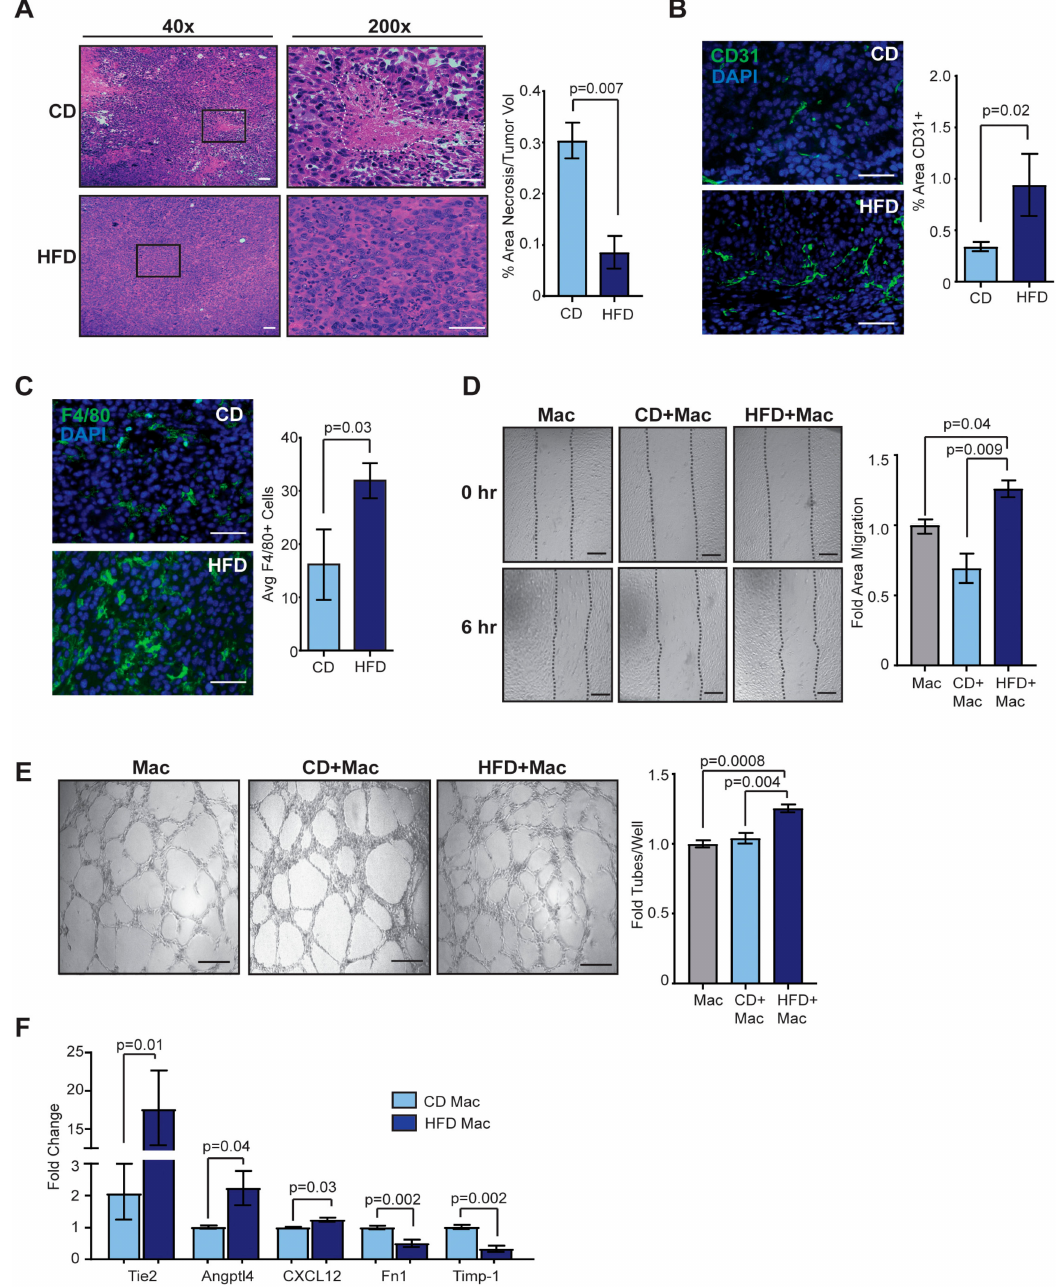
Figure 3. Tumor associated macrophages (TAMs) interact with tumor cells from obese mice to promote angiogenesis. ( A ) Necrotic area was quantified from Met-1 tumors isolated from lean or obese mice ( n = 10 / group, t -test). CD31 expression ( B ) and F4 / 80 + TAMs ( C ) were detected using immunofluorescence and quantified in Met-1 tumors ( n = 6 / group, t -test). Isolated Met-1 tumor cells were co-cultured with THP-1 di ff erentiated macrophages and conditioned media was collected. Human umbilical vein endothelial cells were plated in wound healing assays ( D ) and networking assays ( E ) in the presence of conditioned media ( n = 5 / group, one-way ANOVA analysis with Tukey’s multiple comparison test). ( F ) Primary TAMs were isolated from Met-1 tumors. Expression di ff erences were normalized to cyclophilin and represented as a fold change from controls ( n = 6 / group, t -test). Bars represent mean ± s.e.m. Magnification bars = 50 µ